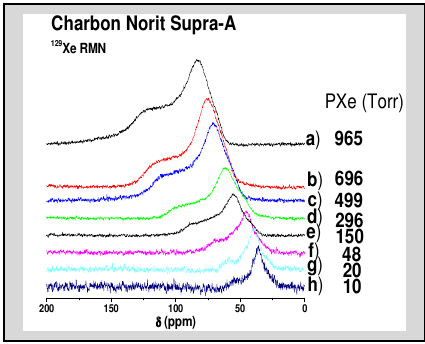
Fig. 4. 129 Xe NMR spectrum of activated carbon Norit A SUPRA EUR at room temperature